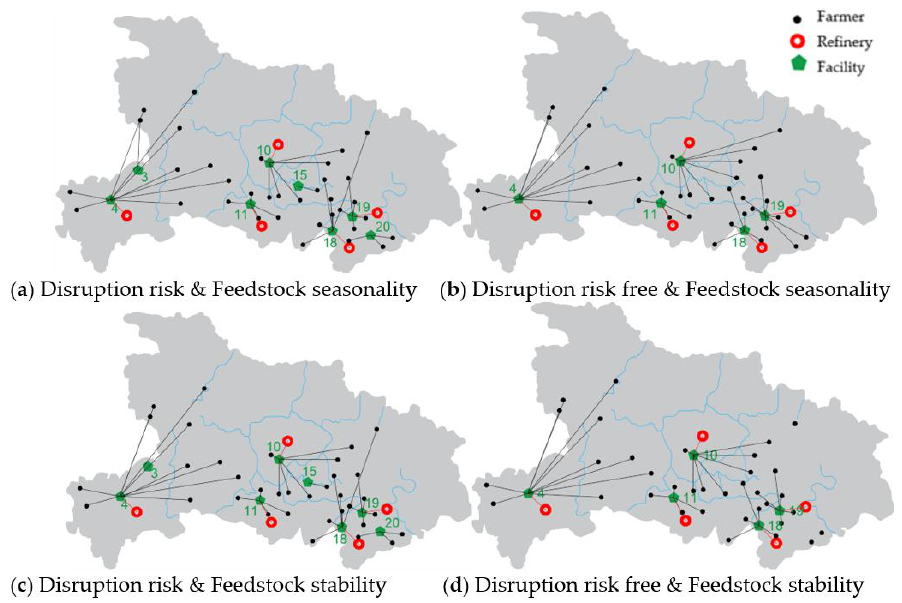
Figure 8. Inventory in the collection facilities.